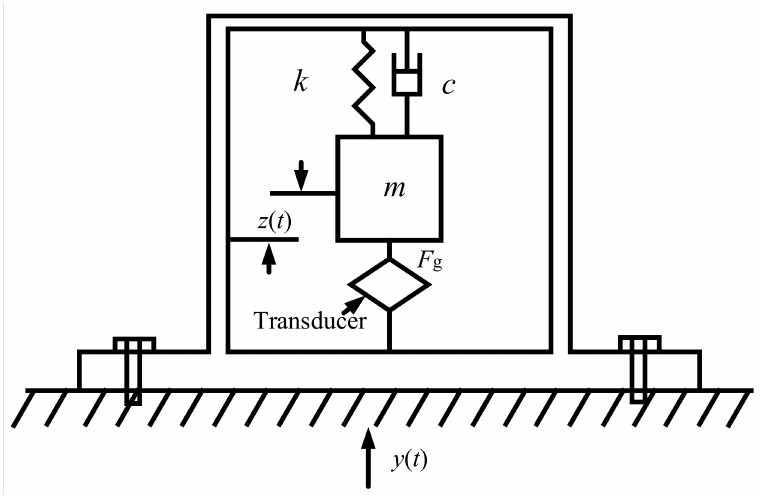
Figure 3. Mechanical model of a vibration energy harvester. Adapted from